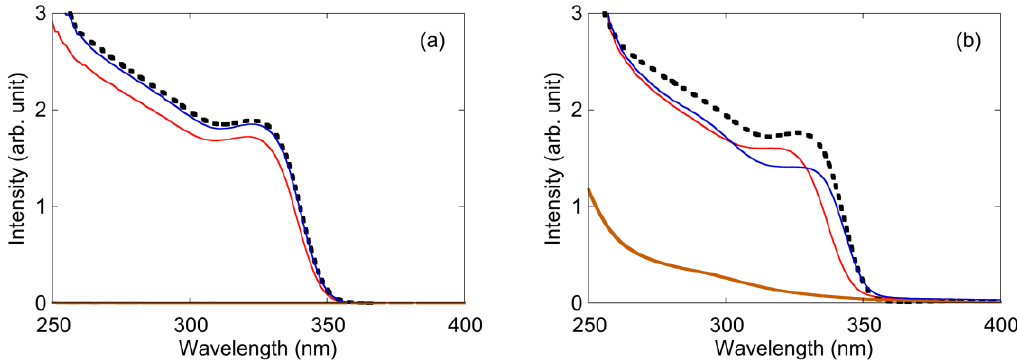
Figure 3. Absorption spectra of the ZnO nanoparticle solution. ( a ) PEG was added to the solution; ( b ) PVP was added to the solution. Black dotted line: polymer was not added to the solution. Red solid line: polymer was added before the synthesis of ZnO nanoparticles. Blue solid line: polymer was added after synthesis. Brown solid line: data of only polymer